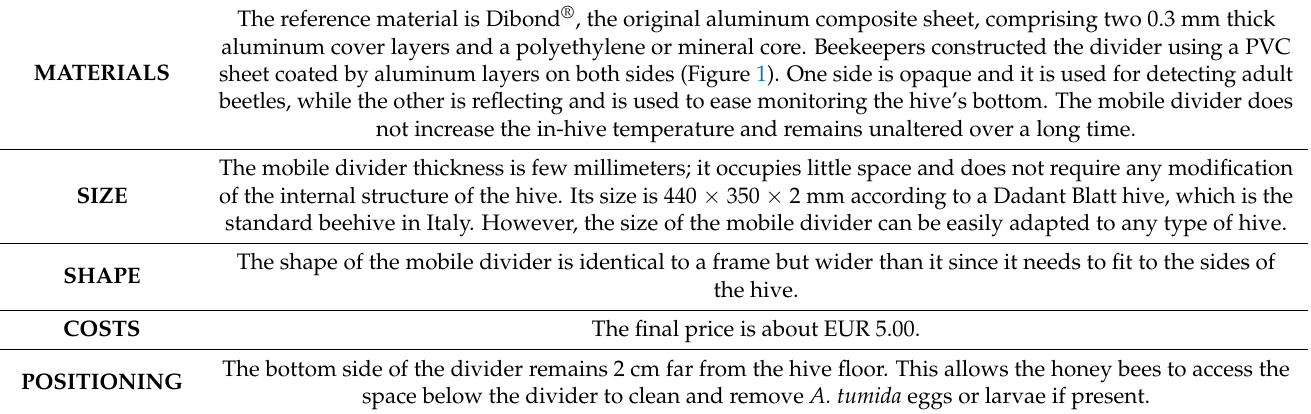
Table 1. Modifications of the original structure of the mobile divider [9] carried out by beekeepers in Calabria region.